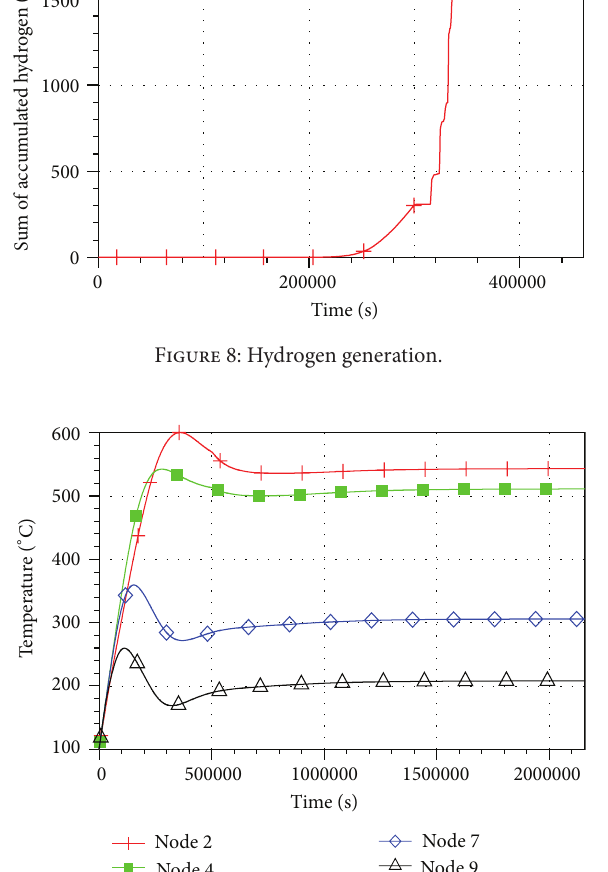
Figure 9: Temperatures of fuel in fuel assemblies ROD1.